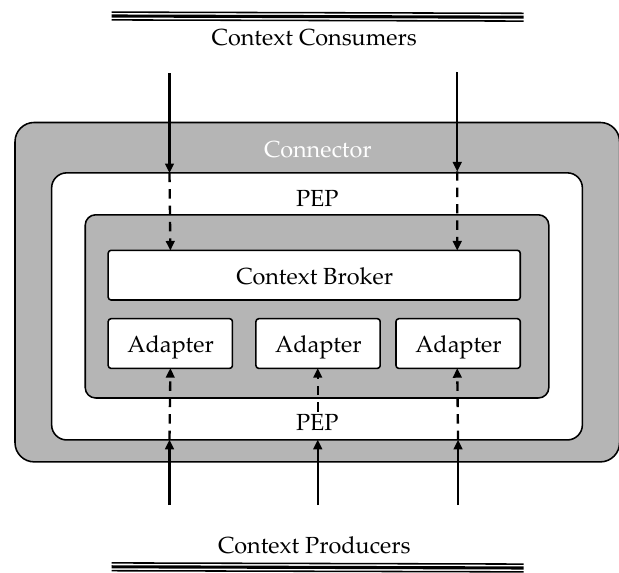
Figure 1. FIWARE IDS